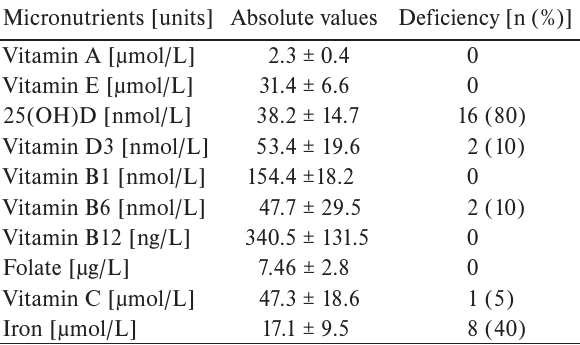
Table 1. Absolute values and rates of deficiency in micronutri- ents in preoperative endoscopic gastric plication